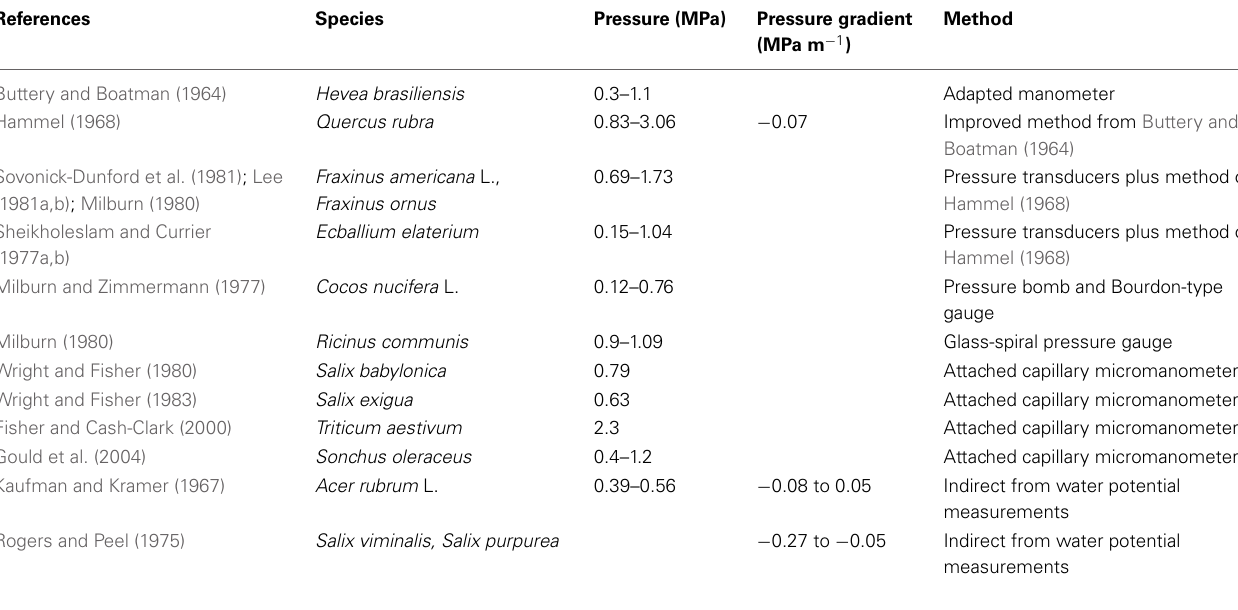
Table A1 | Pressure and pressure gradient measurements on several plant